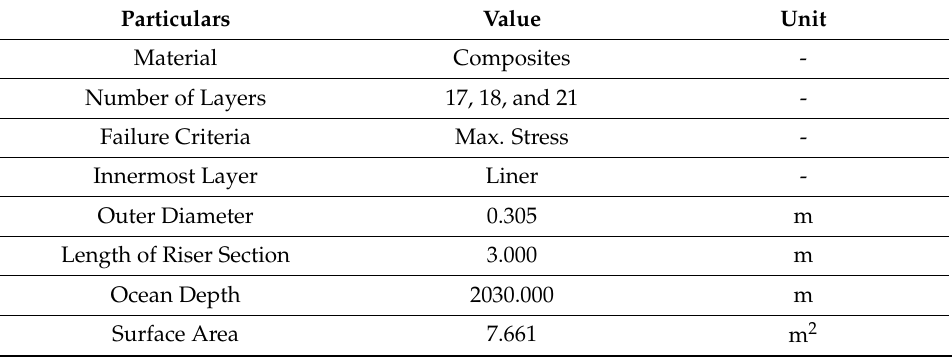
Table 1. Parameters for the composite riser